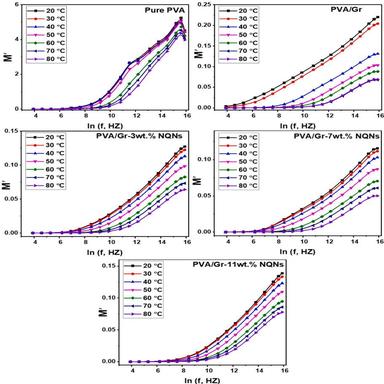
The M′ as a function of ln (f) for the pure PVA and the fabricated PNCs (PVA/Gr, PVA/Gr-3 wt% NQNs, PVA/Gr-7 wt% NQNs, and PVA/Gr-11 wt% NQNs). The measurements were conducted at temperatures (20–80 ◦C) and at different applied frequencies starting from 50 Hz up to 8 MHz.